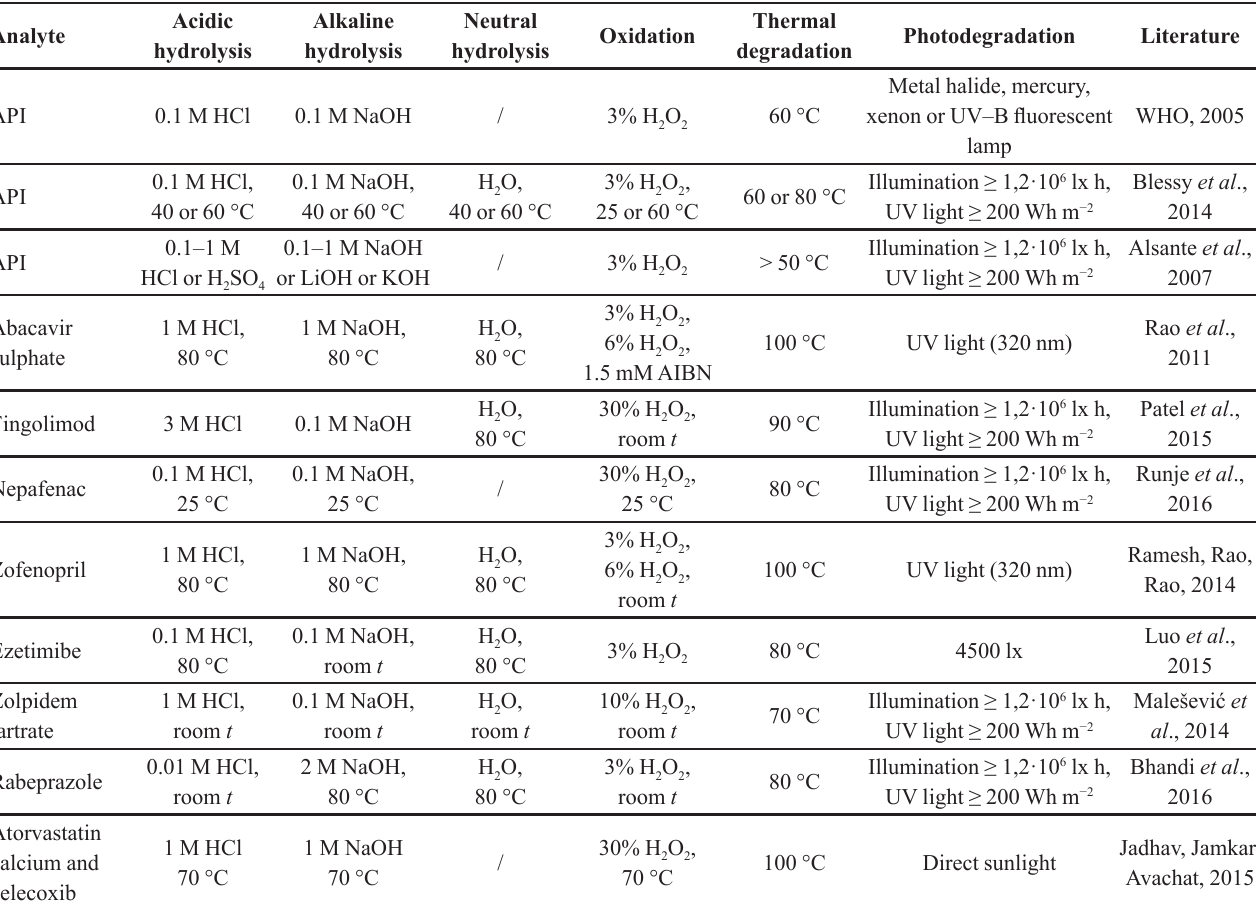
TABLE I - Literature survey of various stress conditions for degradation of different drugs